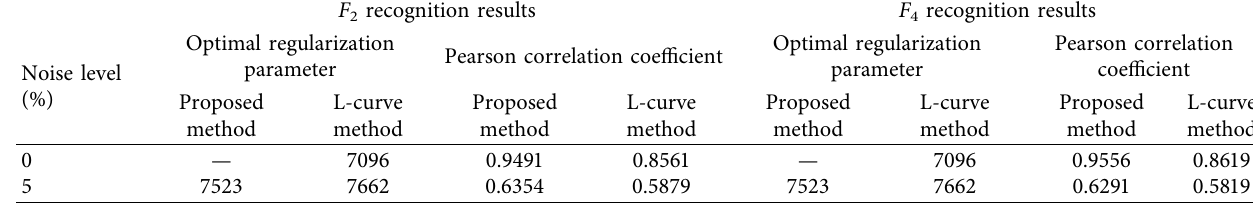
Table 5: Comparison of the calculation results for F 2 and F 4 obtained using the L-curve method and the proposed method.